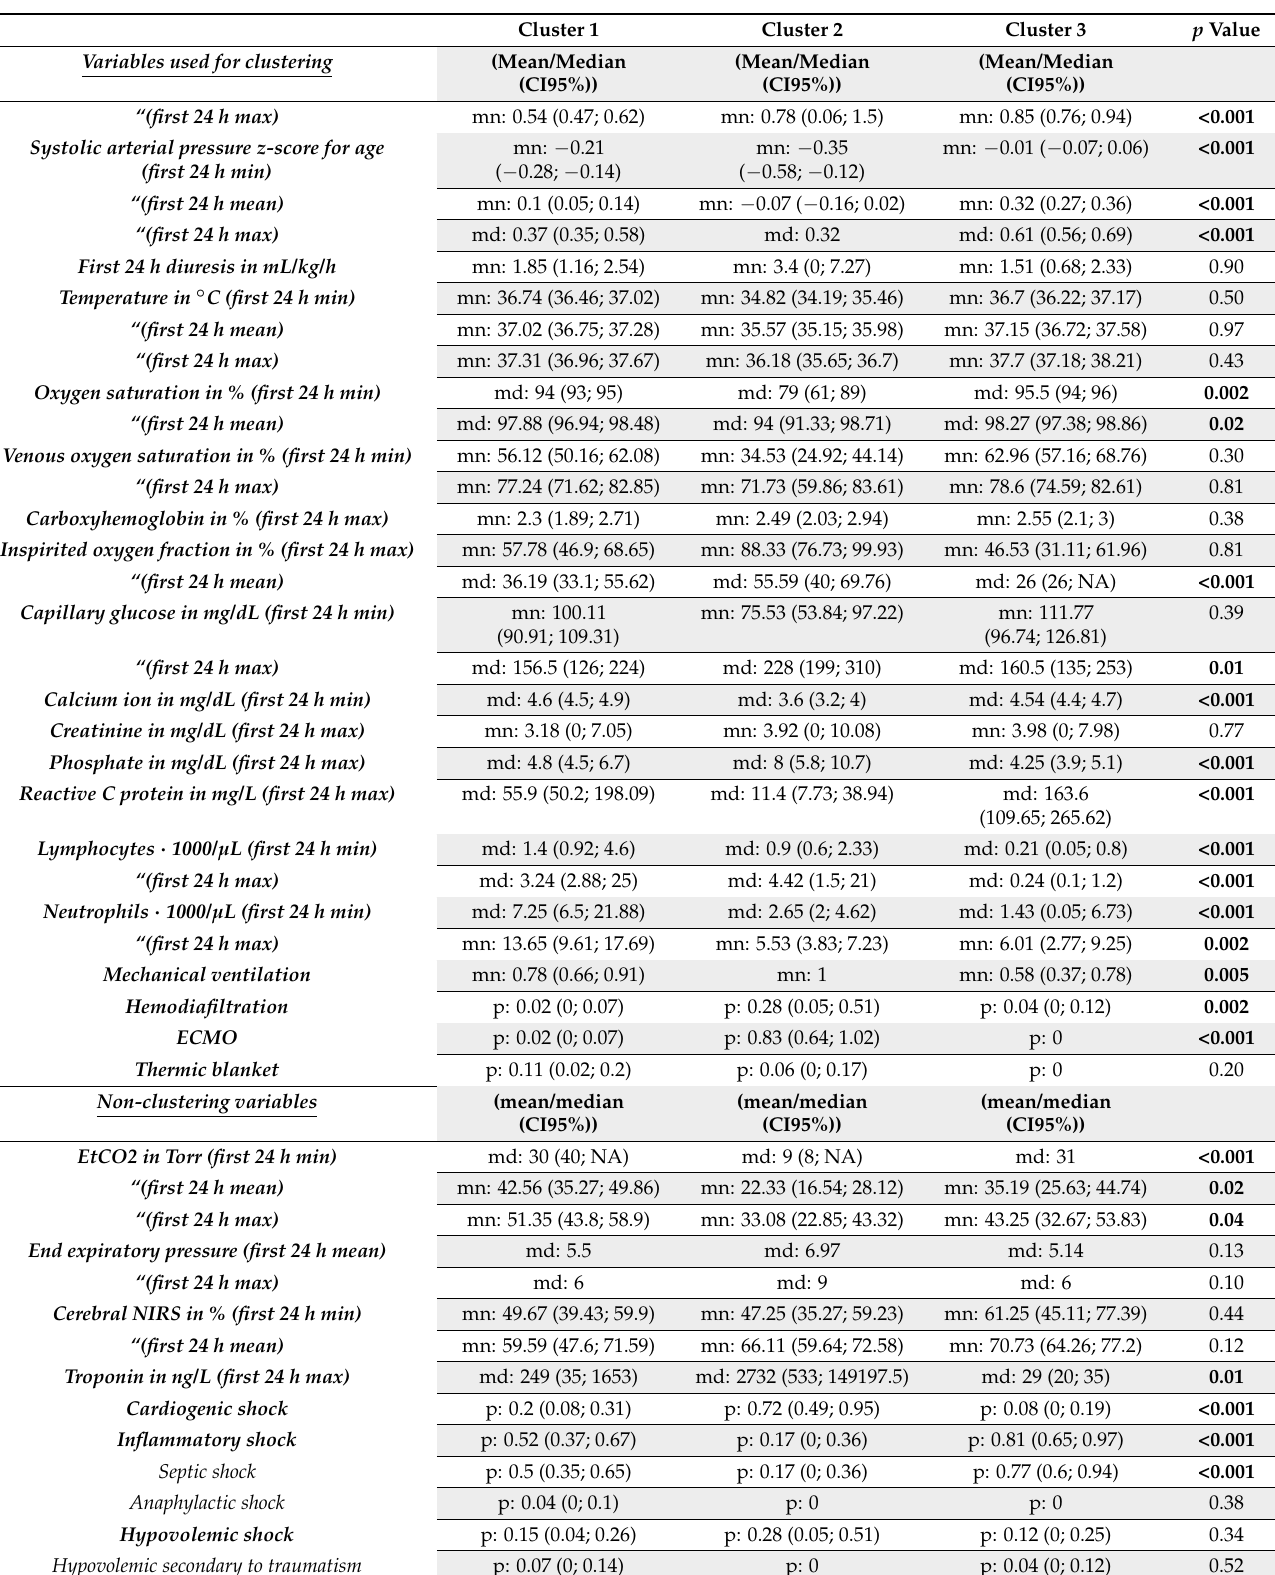
Table A1. Cont. Cluster 1 Cluster 2 Cluster